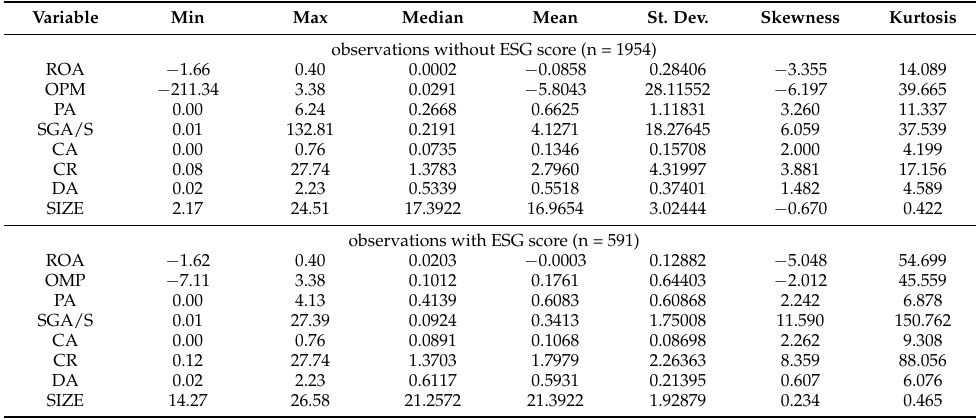
Table A2. Descriptive statistics for the examined financial-performance-related